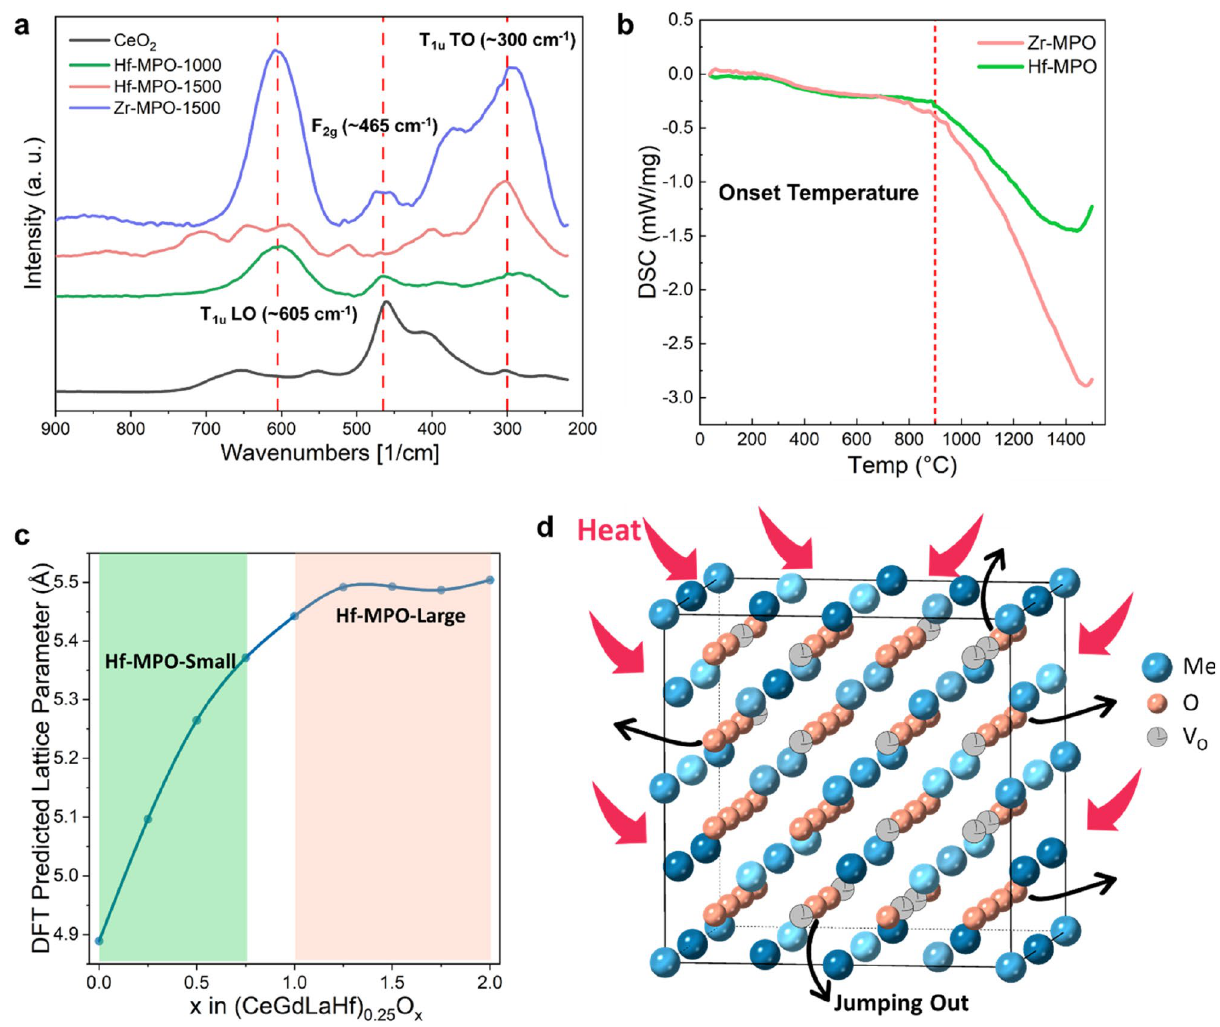
Figure 2. ( a ) Raman spectroscopy of Zr-MPO-1500, Hf-MPO-1500, Hf-MPO-1000, and standard fluorite CeO 2 ). ( b ) DSC curve of Zr-MPO and Hf-MPO. ( c ) Predicted relationship between oxygen contents x of